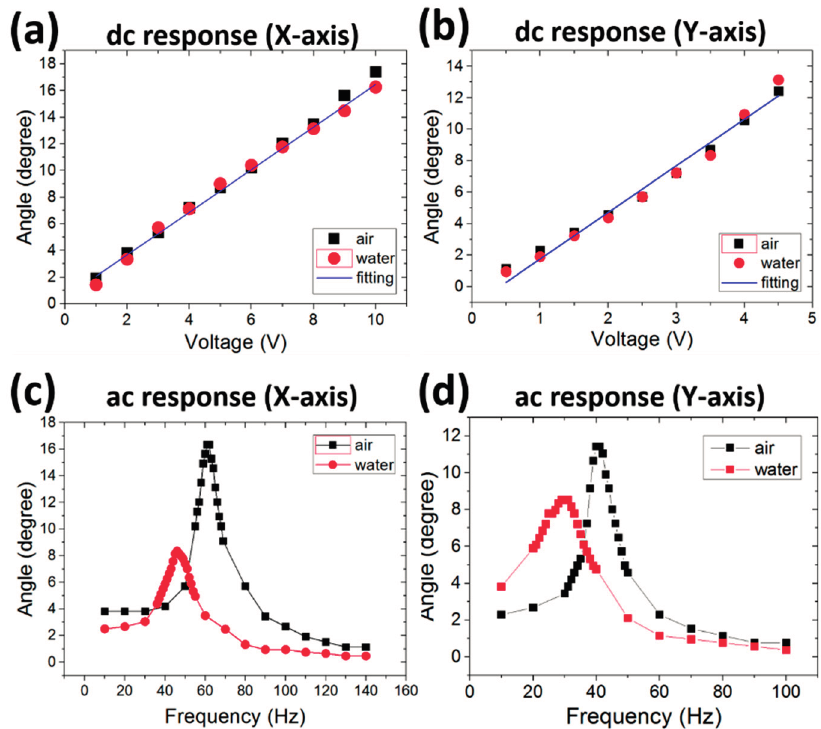
Figure 4. Scanning responses of the 2A-WP-MEMS-scanner in DC and ac conditions. Scanning angles versus the applied DC voltages along the ( a ) X and Y ( b ) axes, respectively. Scanning angles versus the applied ac frequencies at 2 V along ( c ) X and ( d ) Y axes,